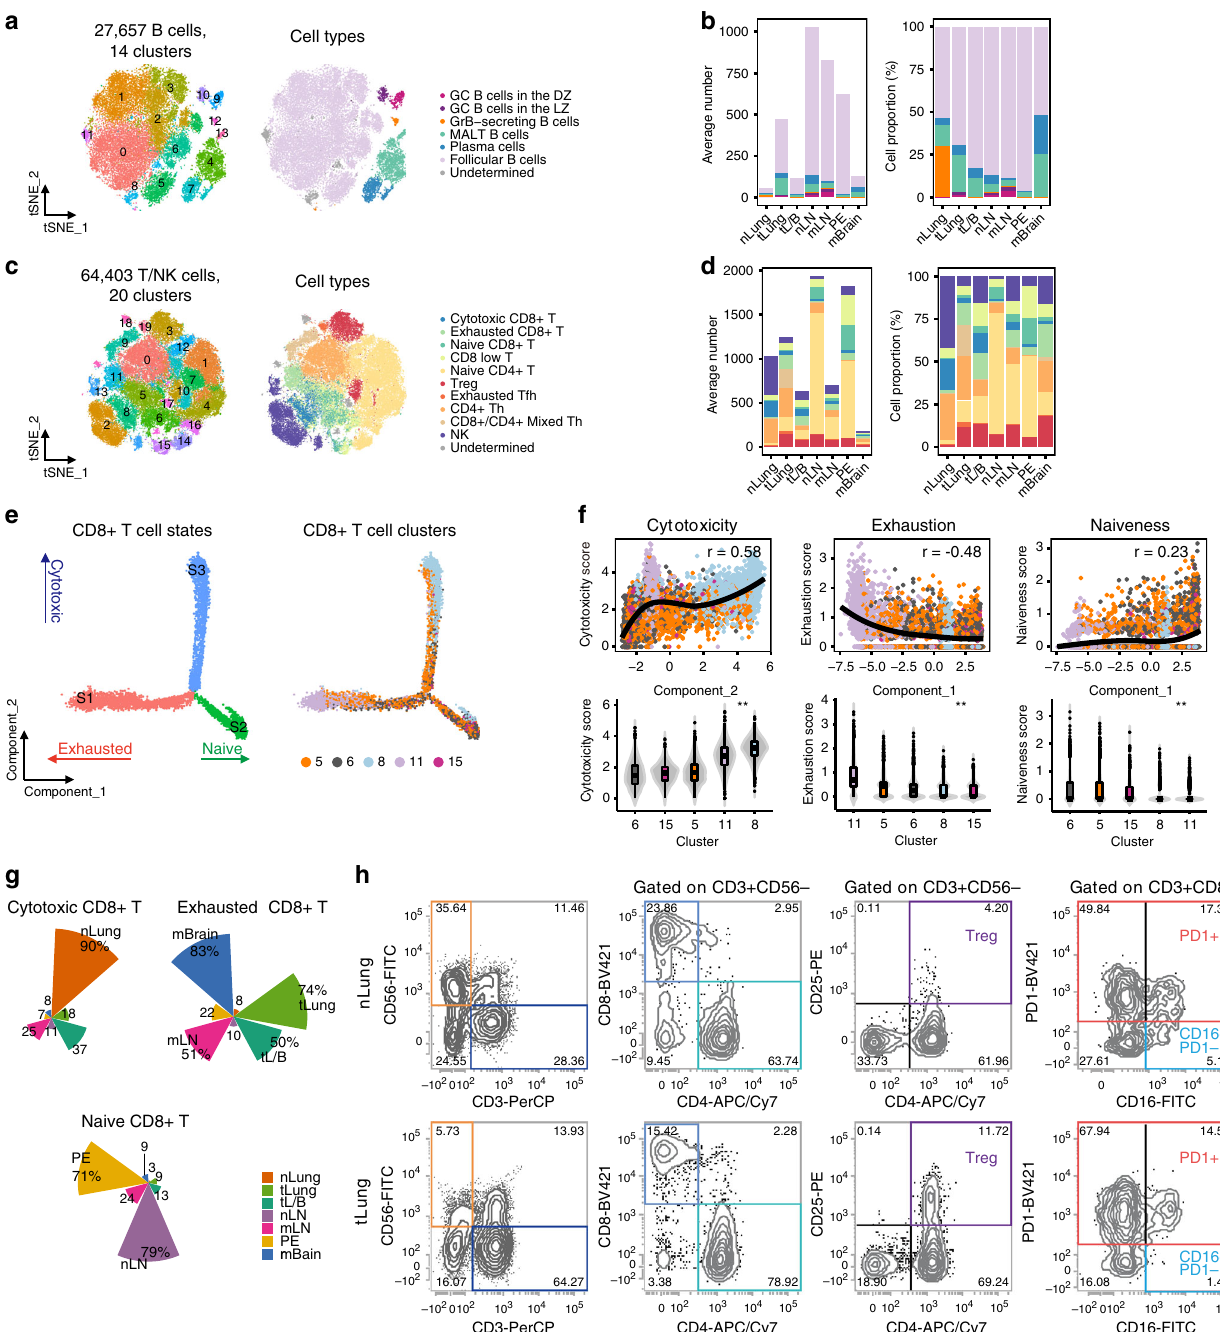
Fig. 5 B cell- and T/NK cell-mediated immune responses during lung cancer progression. a tSNE plot of B cells, color-coded by clusters and cell subsets as indicated. DZ: dark zone; LZ: light zone; GrB, granzyme B; MALT: mucosa-associated lymphoid tissue. b Average cell number and relative proportion of B cell subsets from tissues of each origin (excluding undetermined cells). nLung, n = 11 samples; tLung, n = 11 samples; tL/B, n = 4 samples; nLN, 10 samples; mLN, n = 7 samples; PE, n = 5 samples, mBrain, n = 10 samples. c tSNE plot of T/NK cells, color-coded by clusters and cell subsets as indicated. Tfh: T follicular helper; Th: T helper. d Average cell number and relative proportion of T/NK cell subsets from tissues of each origin (excluding undetermined cells). nLung, n = 11 samples; tLung, n = 11 samples; tL/B, n = 4 samples; nLN, 10 samples; mLN, n = 7 samples; PE, n = 5 samples, mBrain, n = 10 samples. e Unsupervised trajectory of CD8 + T cell functional state transitions. f Correlation of Monocle components with T cell functional features (mean expression of signature genes in Supplementary Fig. 8a). Each dot indicates single cells colored by their clusters. Solid black line and the top-right text (r) denote LOESS fi t and Pearson ’ s correlation, respectively (top). Violin plot of T cell functional features in each cluster (bottom). **, one-way ANOVA test p- value < 0.01. g Tissue distribution along functional states in CD8 + T cells. h Flow cytometry plots gated on NK and T cell subsets (Treg, cytotoxic and exhausted CD8 + T cells) from primary tumor (T08) and normal lung (N08)